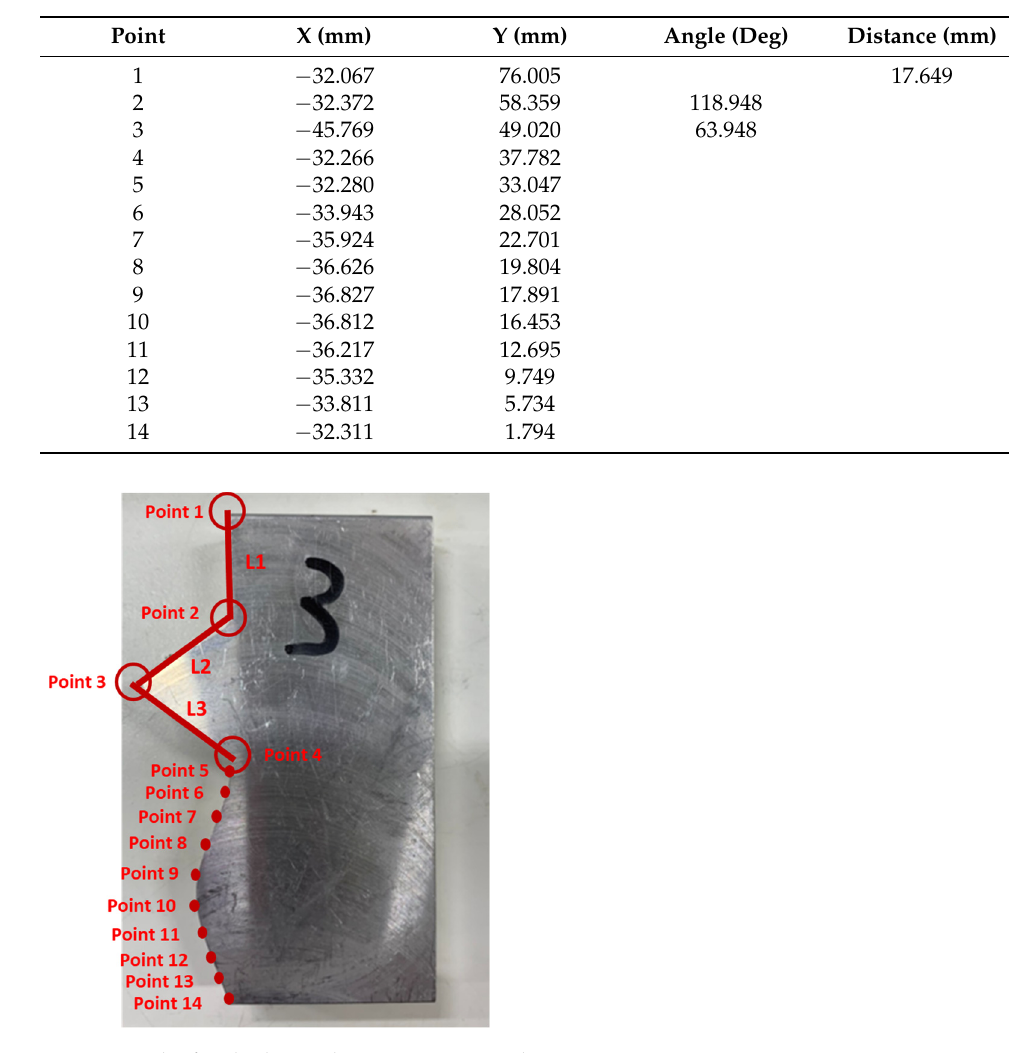
Figure 15. The finished complex part. Table 5. The measured coordinates of complex part.